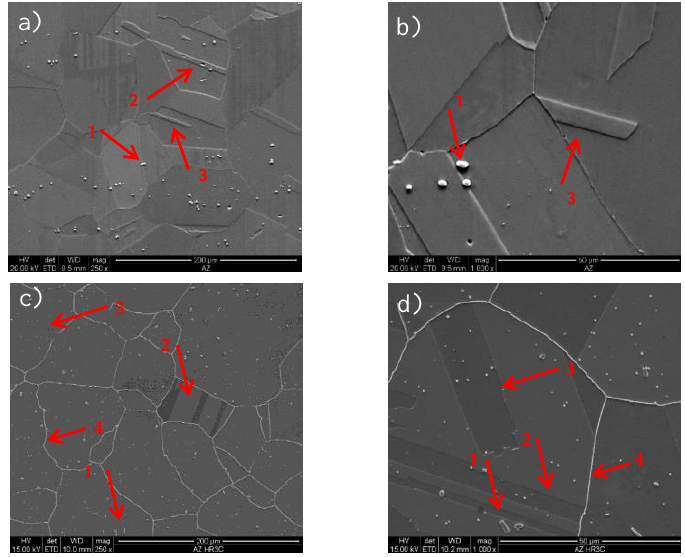
Figure 1. ( a , b ) microstructure of HR3C in the as-received condition, ( c , d ) microstructure of HR3C after service, 1—primary precipitates, 2—coherent twin, 3—incoherent twin, and 4—precipitates at the grain boundary; SEM.